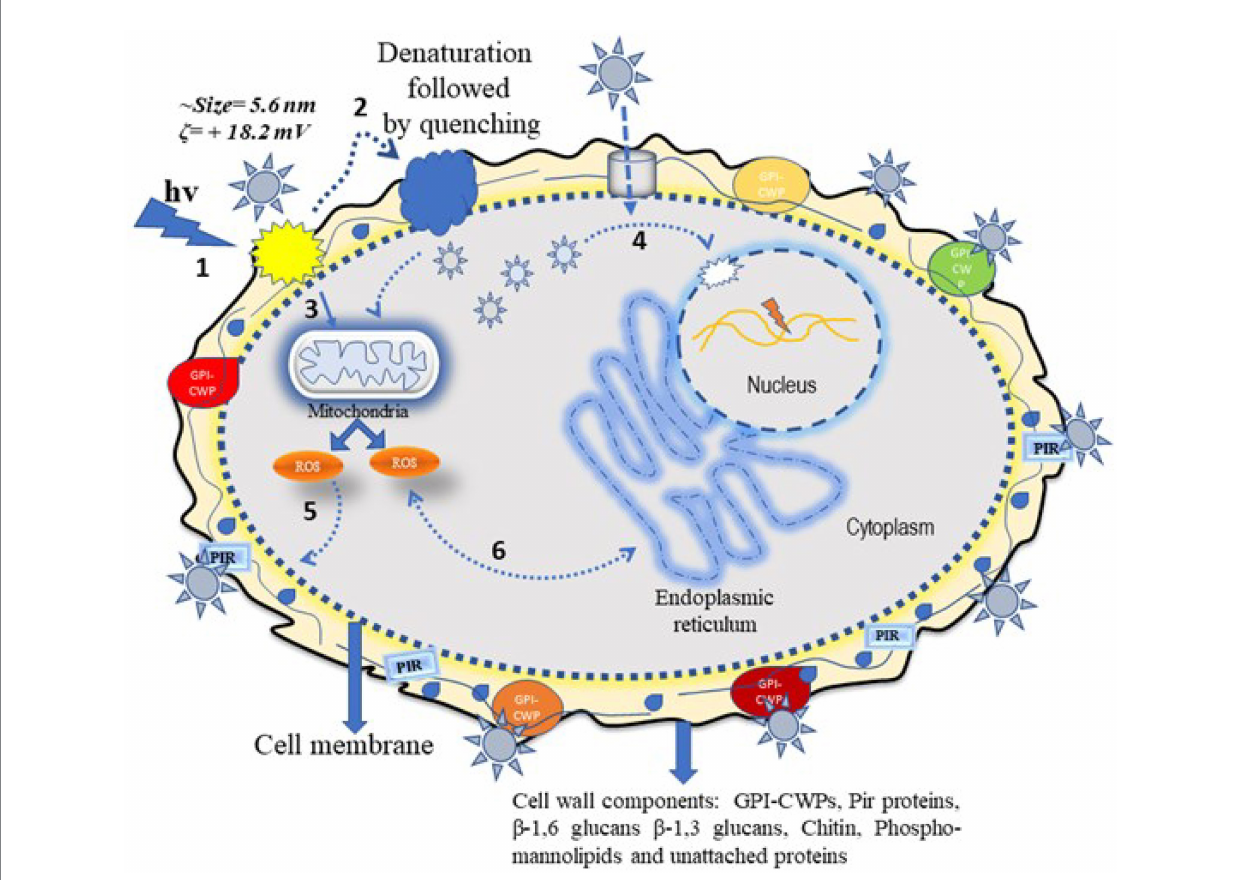
FIGURE 10 Schematic showing the possible antifungal mechanism of polyethyleneimine-functionalized silver nanoparticles. The silver nanoparticle interacts with C. albicans cells via two different pathways, which can be direct or indirect. In the direct pathway, the cationic Ag-NPs interact electrostatically with surface structural proteins and phosphor-mannolipids; these processes induce electrostatic stress followed by ROS generation and inactivation of cytoplasmic proteins. In addition, nanoparticle-generated stress induces mitochondrial ROS inside the cell, which damages cytoplasmic biomolecules such as proteins and DNA through oxidation. The ROS can also damage the cell membrane through lipid peroxidation, resulting in membrane perforation and eventual cell death (steps 1, 2, 3, 5, and 6) as indicated in the diagram. The indirect action involves silver nanoparticles passing through the cell wall/membrane via water channels or other channels and becoming internalized inside the cell. These silver nanoparticles disintegrate the cytoplasmic biomolecules (e.g., structural proteins and enzymes) and nuclear DNA, collapsing cell cytoarchitecture and resulting in cell death (step 4) as indicated in the